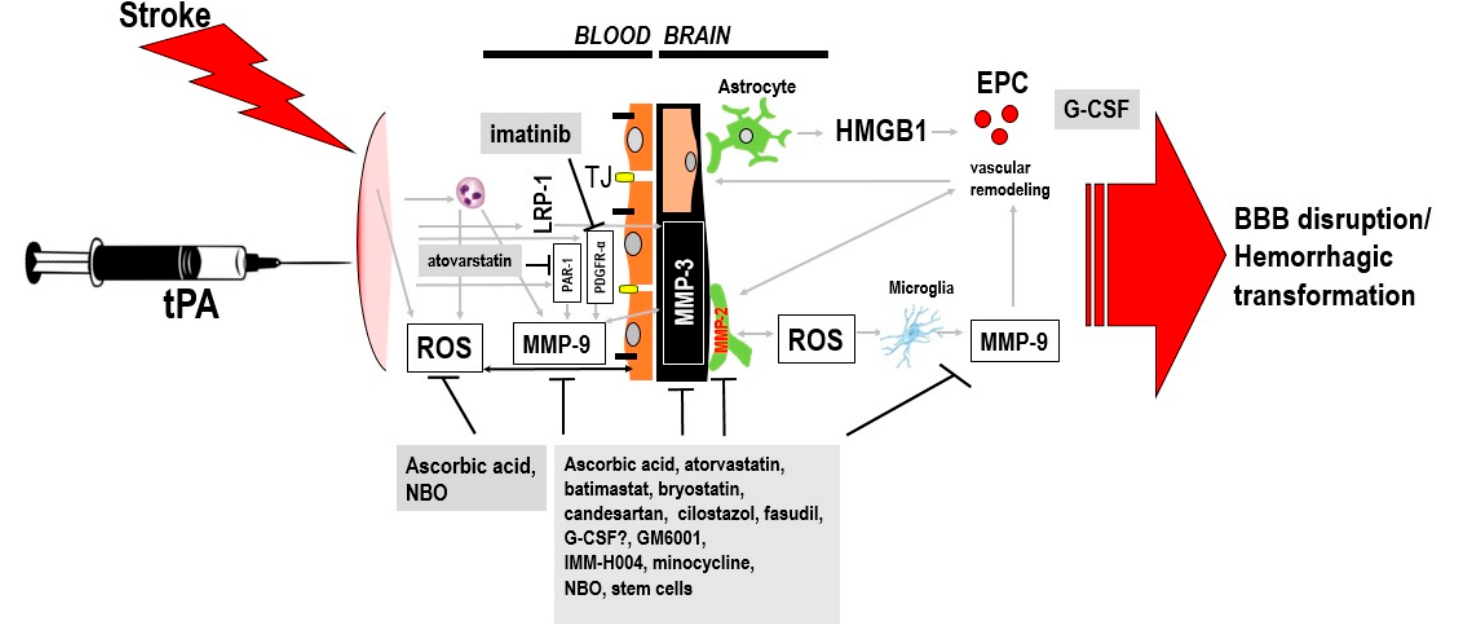
Figure 1. Proposed molecular targets of adjunctive treatments to enhance therapeutic window of tissue plasminogen activator (tPA) treatment. Acute stroke may cause injury to endothelial cells causing release of free radicals and pro-inflammatory cytokines. The signaling actions of tPA on the neurovascular unit may also increase blood-brain barrier (BBB) leakage, neurovascular cell death, and hemorrhagic transformation (HT). Moreover, the HT that ensues after delayed tPA treatment has been attributed to increased reperfusion and the effect of tPA on metalloproteinase (MMP) activity and other signaling pathways, including lipoprotein receptor-related protein (LRP), protease-activated receptor (PAR1), and PDGRF- α signaling. Ascorbic acid, normobaric oxygen (NBO) attenuates delayed tPA-induced complications in preclinical stroke models via inhibition of ROS production and BBB protection. Atovarstatin, minocycline, cilostazol, GM6001, fasudil, candesartan, bryostatin, and IMM-H004 reduces the HT by preserving the BBB through their actions on various MMPs and tight junction proteins. Granulocyte-colony stimulating factor (G-CSF) and IMM-H004 may reduce the HT by enhancing neurovascularization in addition to restoring BBB integrity. Imatinib reduces HT through the PDGRF- α receptor, while atovarstatin exerts its therapeutic benefits via inhibition of PAR1. Stem cells may also exert multi-pronged effects including BBB protection via its actions on various matrix metalloproteinases (MMPs). Abbreviations: EPC, endothelial progenitor cell; G-CSF, granulocyte-colony stimulating factor; HMGB1, high-mobility-group-box-1; ROS, reactive oxygen species; LRP, lipoprotein receptor-related protein; PAR1, protease-activated receptor; PDGFR- α , platelet-derived growth factor α -receptor (PDGFR- α ); NBO, normobaric oxygen.